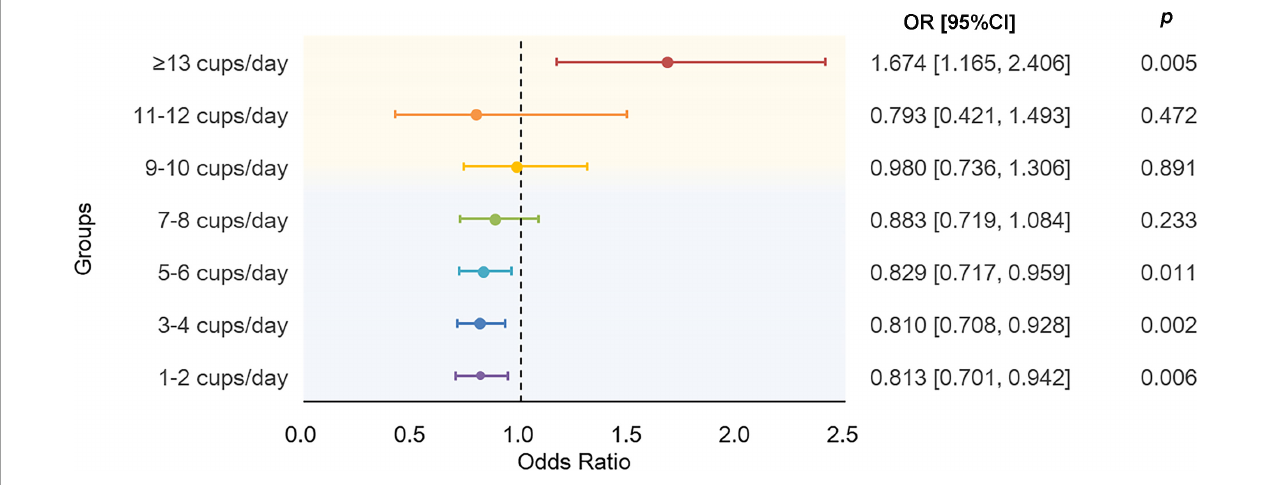
FIGURE4 Results of association analysis using a generalized linear regression model. The model were adjusted by age at baseline, sex, education level, BMI, TDI, sleep_duration, total vegetable intake, total fruit intake, total fish intake, smoking status, and alcohol drinking status. BMI, body mass index; TDI, Townsend deprivation